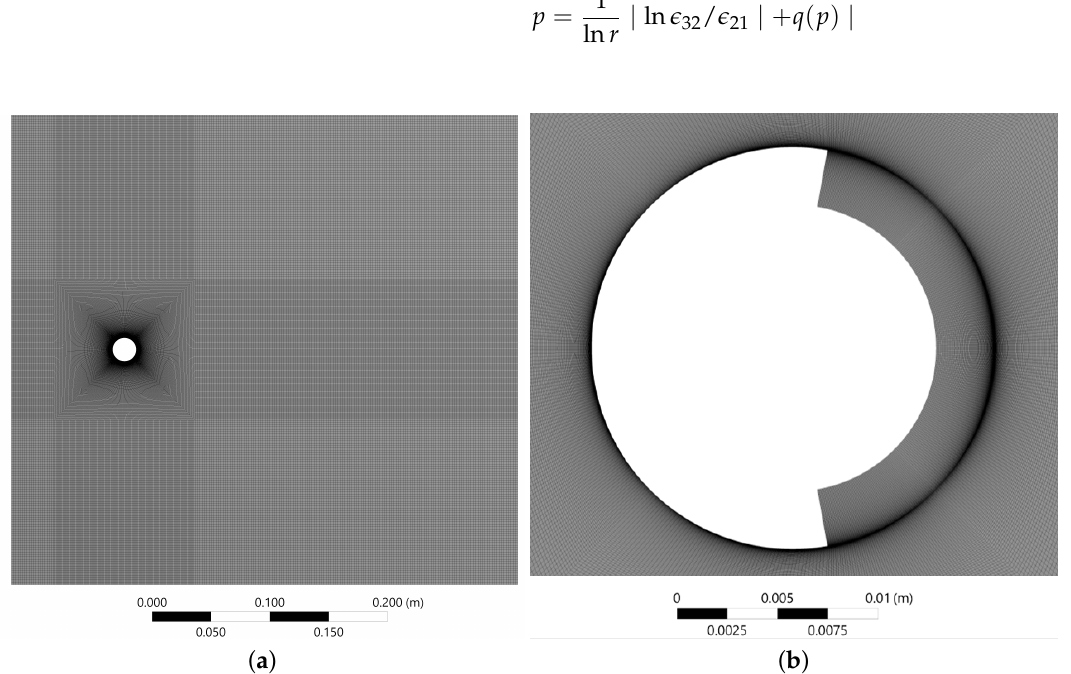
Figure 3. ( a ) A structured mesh developed for the solid cylinder case with 155,000 mesh elements. ( b ) Mesh for a 160 ◦ porous